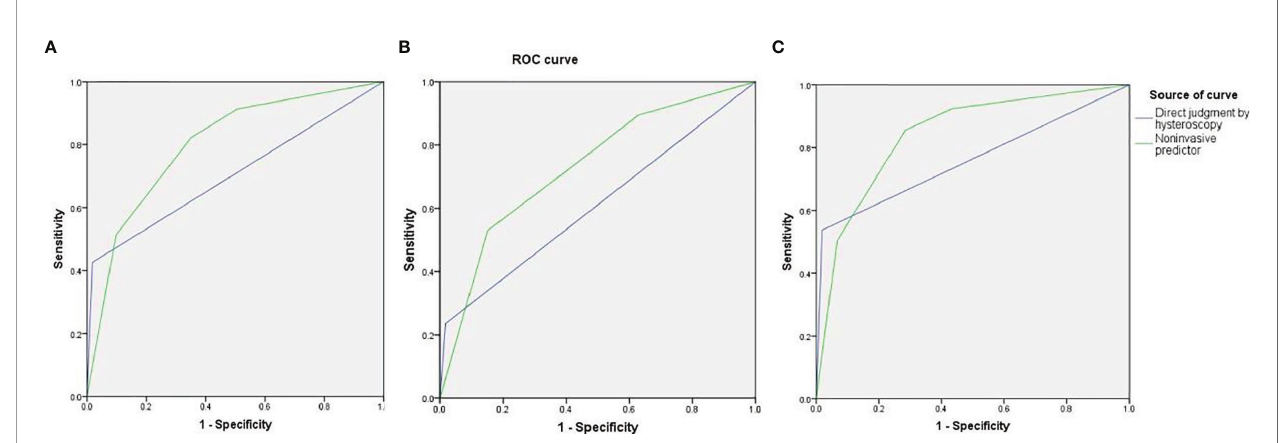
FIGURE 2 | The area under the curve (AUC) of direct judgment by hysteroscopy and noninvasive predictor in total patients (A) , premenopausal patients (B) , and postmenopausal patients (C)